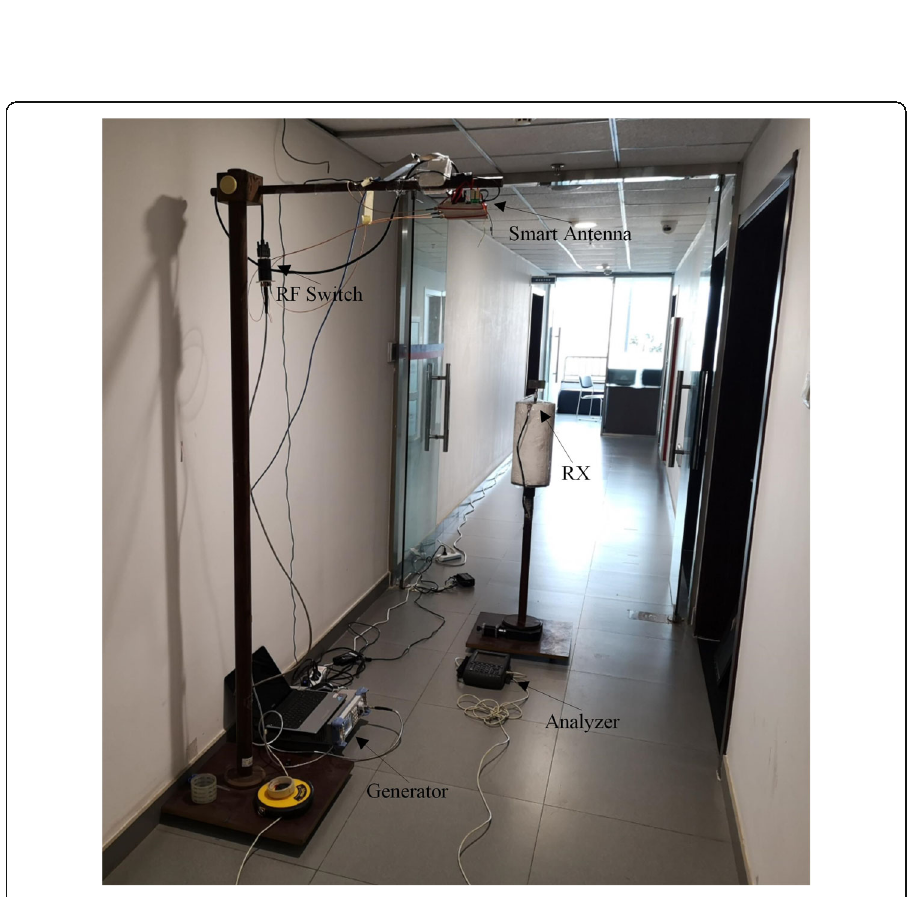
Fig. 13 Setup of receiving level measurement of the smart